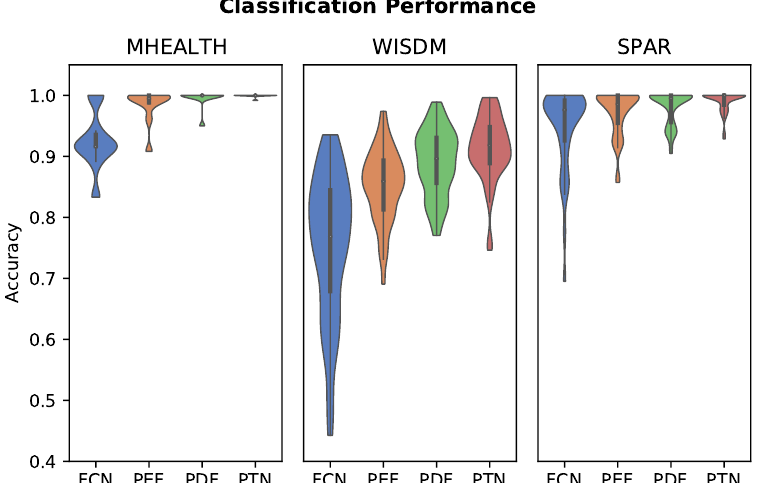
Figure 2. Violin plots showing the distribution of classifier performance by subject using five-fold cross validation. The distributions are cut-off at the minimum and maximum accuracy values. The personalized classifiers have better performance and less inter-subject performance variation than the impersonal FCN (fully convolutional network)